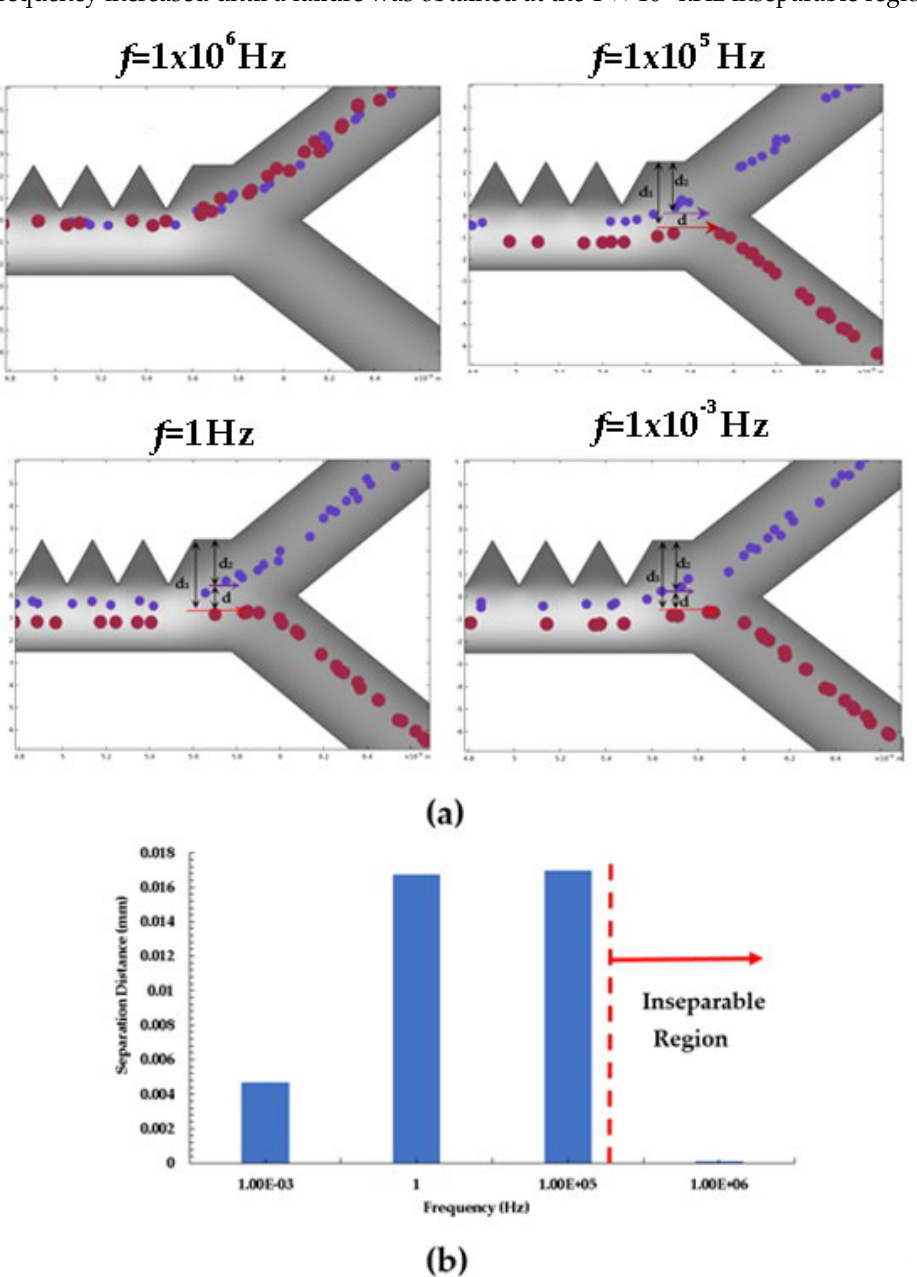
Figure 19. Effects of frequency on RBC separation: ( a ) Separation contours under different driving frequencies of 1 × 10 − 3 Hz, 1 Hz, 1 × 10 5 Hz, and 1 × 10 6 Hz. Blue color arrows mean the flow trajectory of the platelet and red color arrows mean the RBC flow trajectory. ( b ) Comparison of RBC and platelet separation distances with different driving frequencies. The relative size of the RBCs has been divided by two.